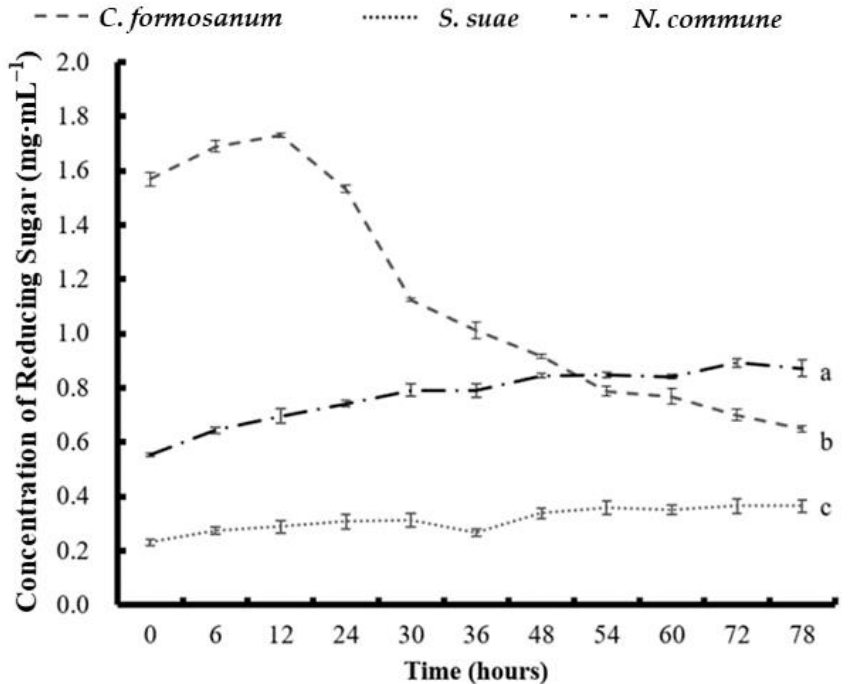
Figure 5. The concentration of reducing sugar in (a) Colaconema formosanum , (b) Sarcodia suae , and (c) Nostoc commune as substrates fermented with Pseudoalteromonas haloplanktis , ATCC 14393. Table 1. Colaconema formosanum , Sarcodia suae , and Nostoc commune through enzyme hydrolysis have different levels of monosaccharides before and after fermentation assayed by NMR analysis.